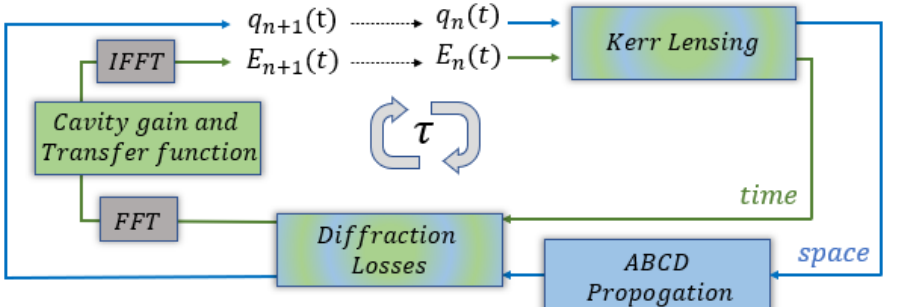
Figure 6. Flowchart of the simulation. The roundtrip time is denoted τ , and includes a spatial part (outer loop—blue), which propagates the beam parameter q ( t ) through the cavity with the ABCD formalism; and a temporal part (inner loop—green), which propagates the field in time E ( t ) from one roundtrip to the next according to the spectral transfer function of the cavity, which includes gain saturation and the spectral gaincurve, loss and chromatic dispersion (all conveniently calculated in the frequency domain with a fast Fourier transform—FFT). The two parts are coupled together via the Kerrlensing effect and the diffraction losses, where the temporal intensity dictates the instantaneous nonlinear lens and the temporal beam parameter q ( t ) dictates the instantaneous diffraction